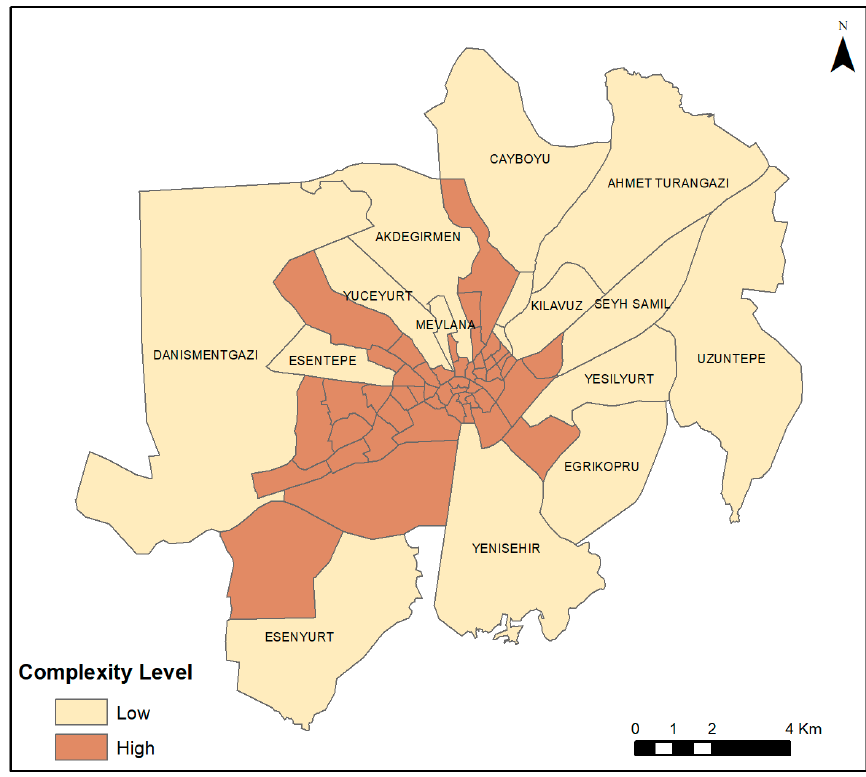
Figure 7. Distribution of complexity levels.